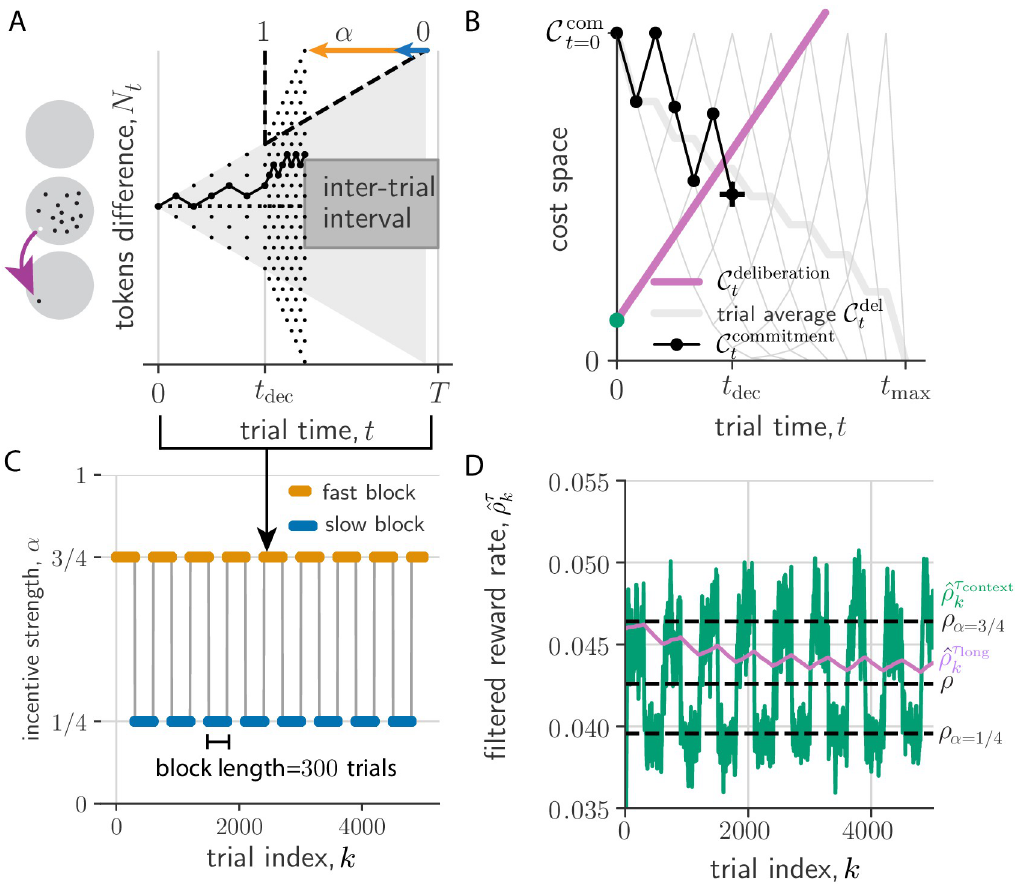
Fig 3. PGD agent performs the tokens task for periodic context switching. (A) A tokens task trial. Left: Tokens jump from a center to a peripheral region (gray circles). Right: The tokens difference, N t , evolves as a random walk that accelerates according to α (here 3/4) post-decision time, t dec . The trial duration is T , which includes an inter-trial interval. (B) Decision dynamics in cost space obtained from evidence dynamics in (A). Commitment cost trajectories (gray lattice; thick gray: trial-averaged) start at C com and end at 0. Trajectory from (A) shown in black. t dec (black cross) is determined by the crossing of the commitment and t ¼ 0 deliberation cost. (C) Incentive strength switches between two values every 300 trials. (D) Expected rewards filtered on τ long ( ^ r t long , purple) and τ context ( ^ r t context , green). Black dashed lines from bottom to top are ρ α =1/4 , ρ , and ρ α =3/4 k k